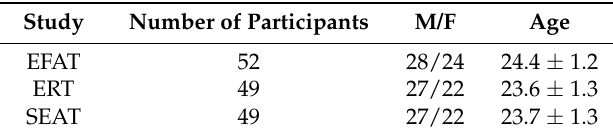
Table 1. Demographic data of the two groups of participants in the three studies. EFAT: Emotional Face Assessment Task; ERT: Emotion Regulation Task; SEAT: Shifting Emotion Attention